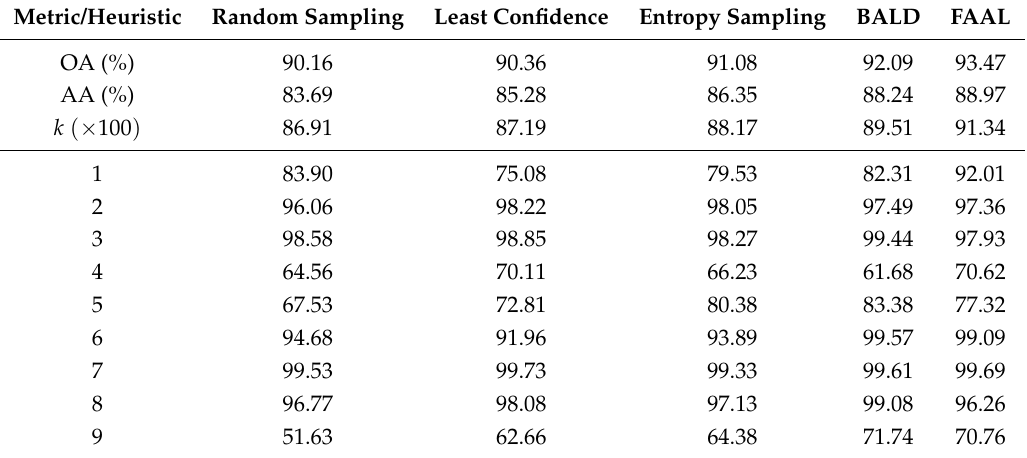
Table 8. Comparison of the classifier with different acquisition heuristics on Pavia University.